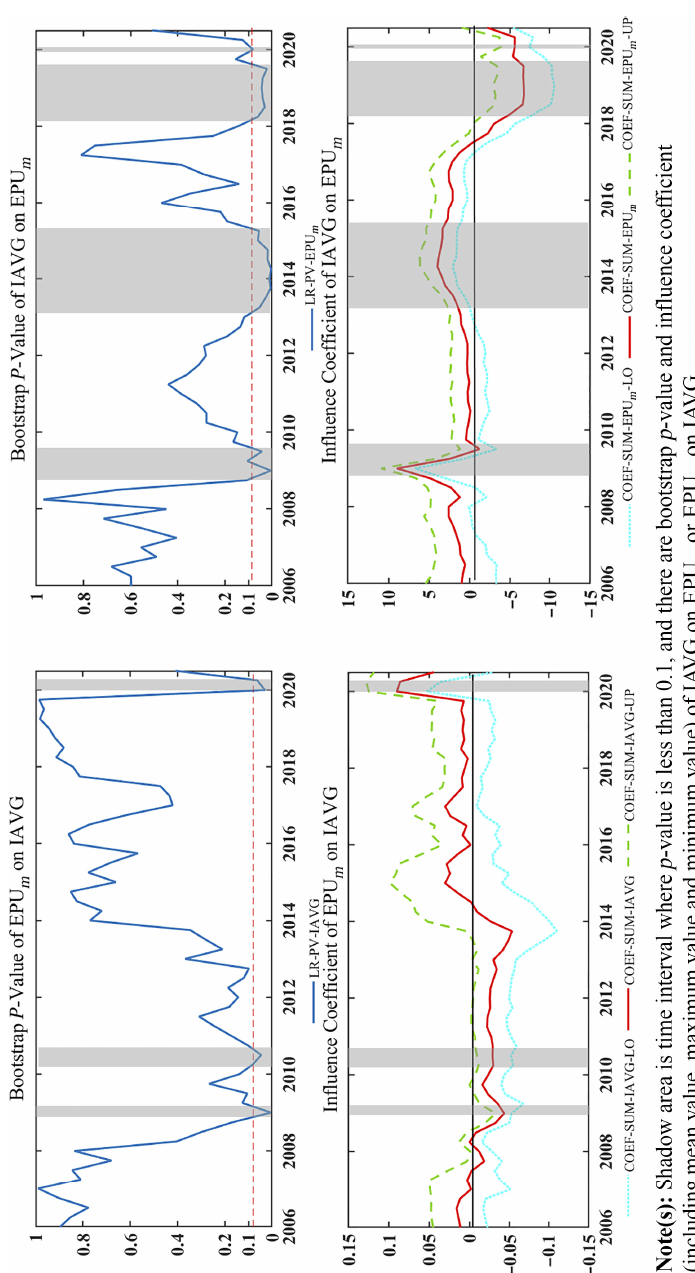
Figure 4. Sub-sample bootstrap rolling window causality test of EPU m and